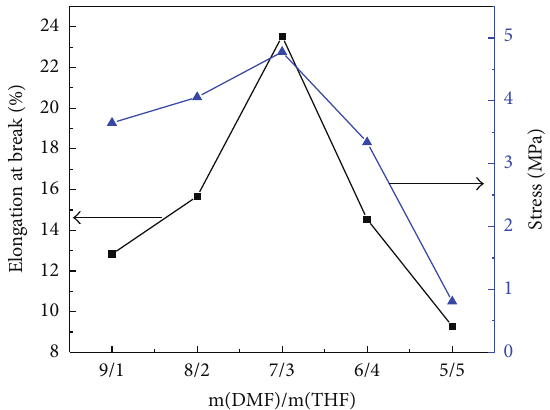
Figure 10: The mechanical properties of different solvent ratio PVDF/PEI composite fiber membranes prepared by electrospin-